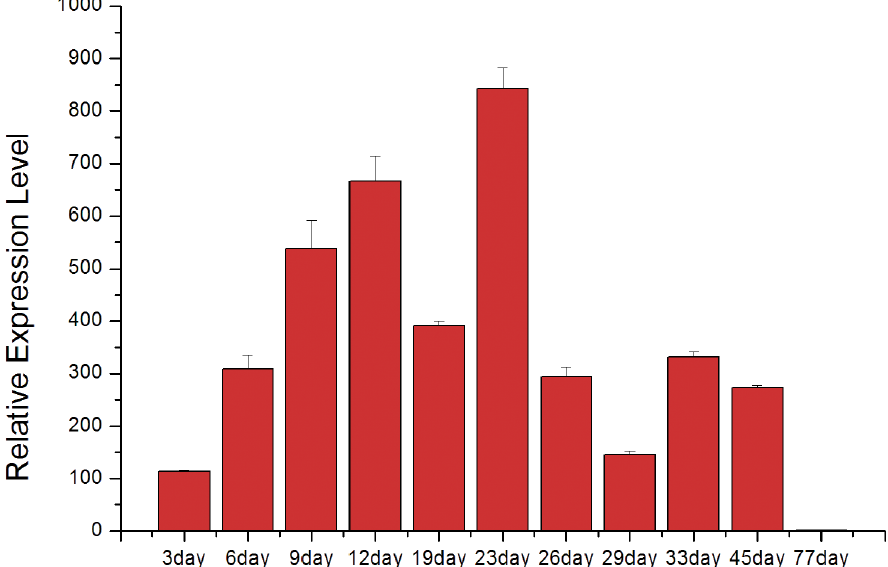
Fig 7. The relative expression level of hic31 in the pearl sac during the early stages of pearl formation after implantation.